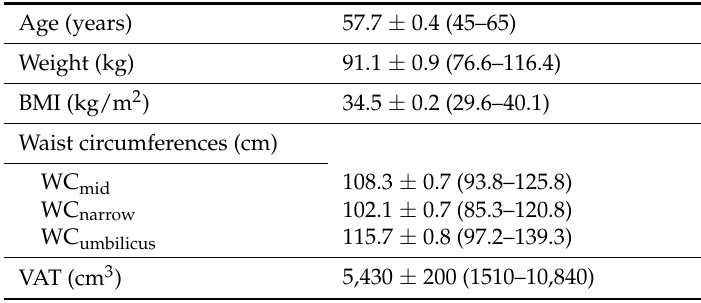
Table 1. Clinical and anthropometric characteristics of participants.